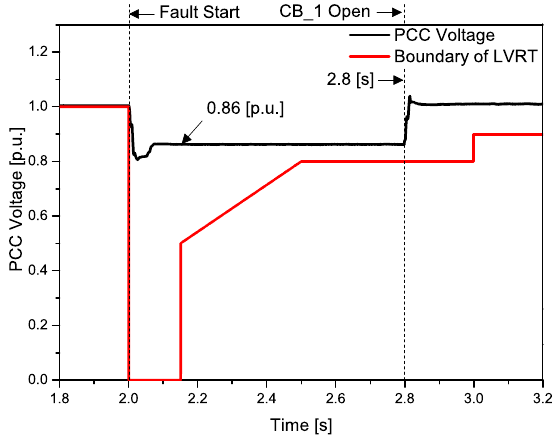
Figure 15. PCC voltage when the OCR is reset.